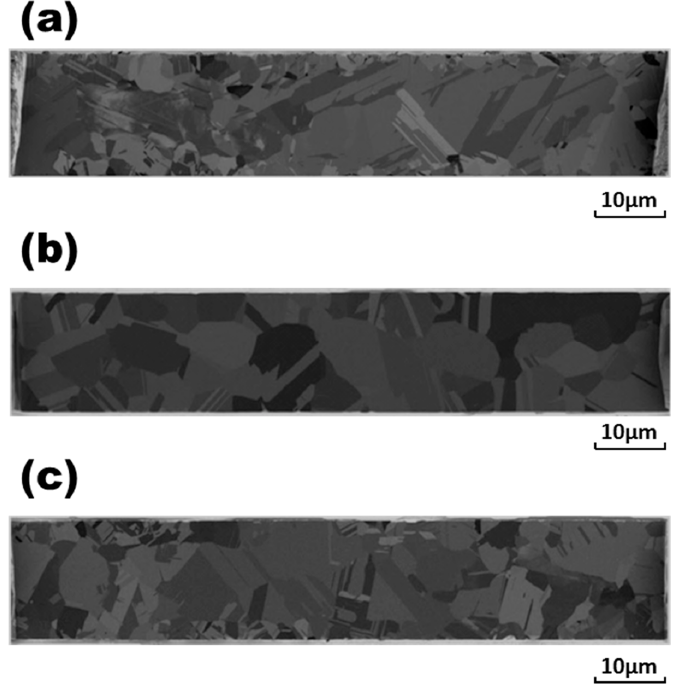
Figure 3. FIB image shows the grain structures in longitudinal cross ‐ sections of the Ag ‐ 0.5Pd wire after current stressing at 1.23 × 10 5 A/cm 2 for various times: ( a ) original; ( b ) 1 h; ( c ) 20 h.